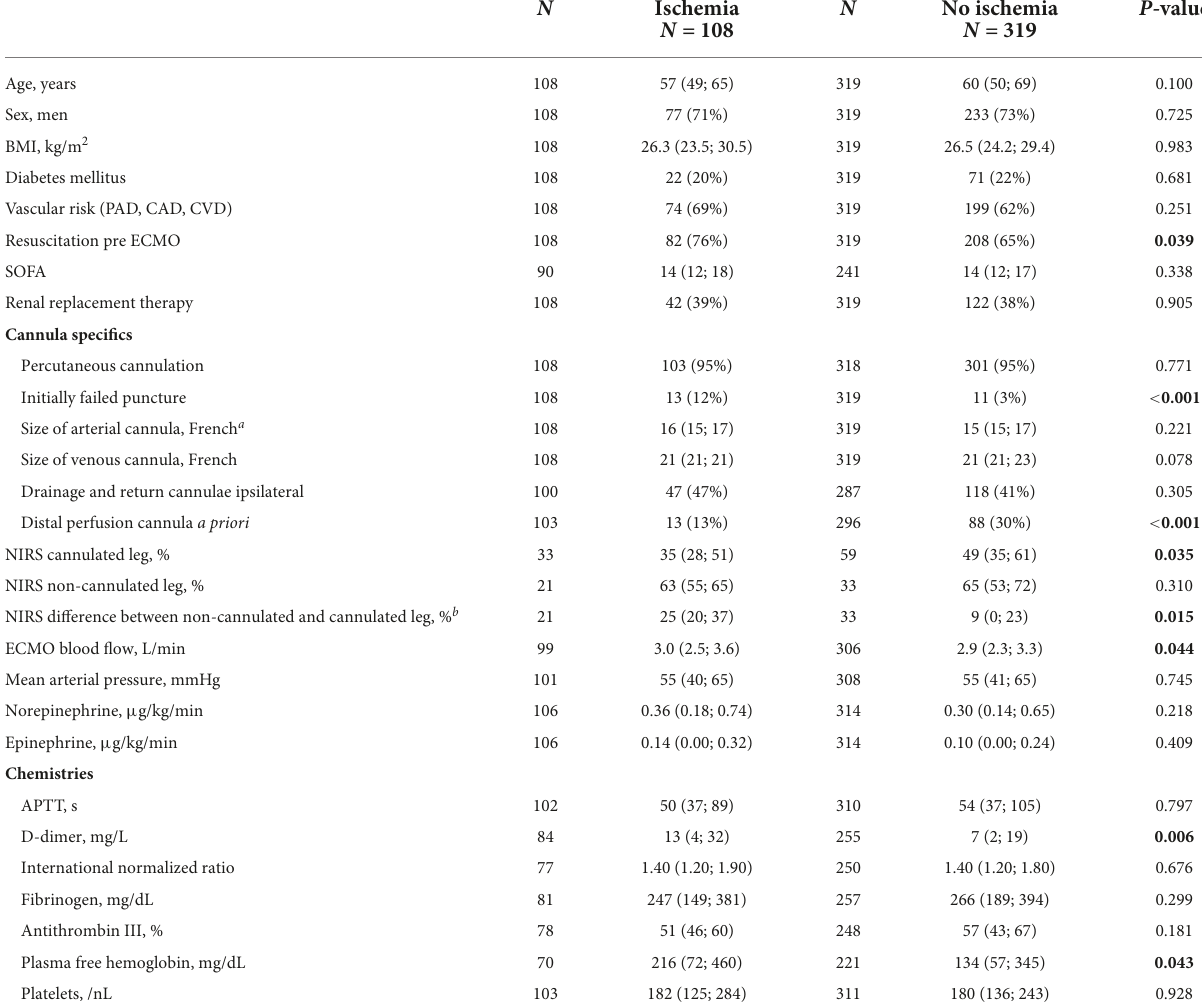
TABLE 3 Patient characteristics at the time of cannulation with regard to ischemia.